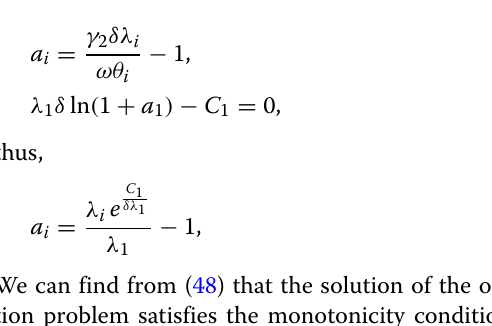
Fig. 3 that each type of UE will obtain the largest reward